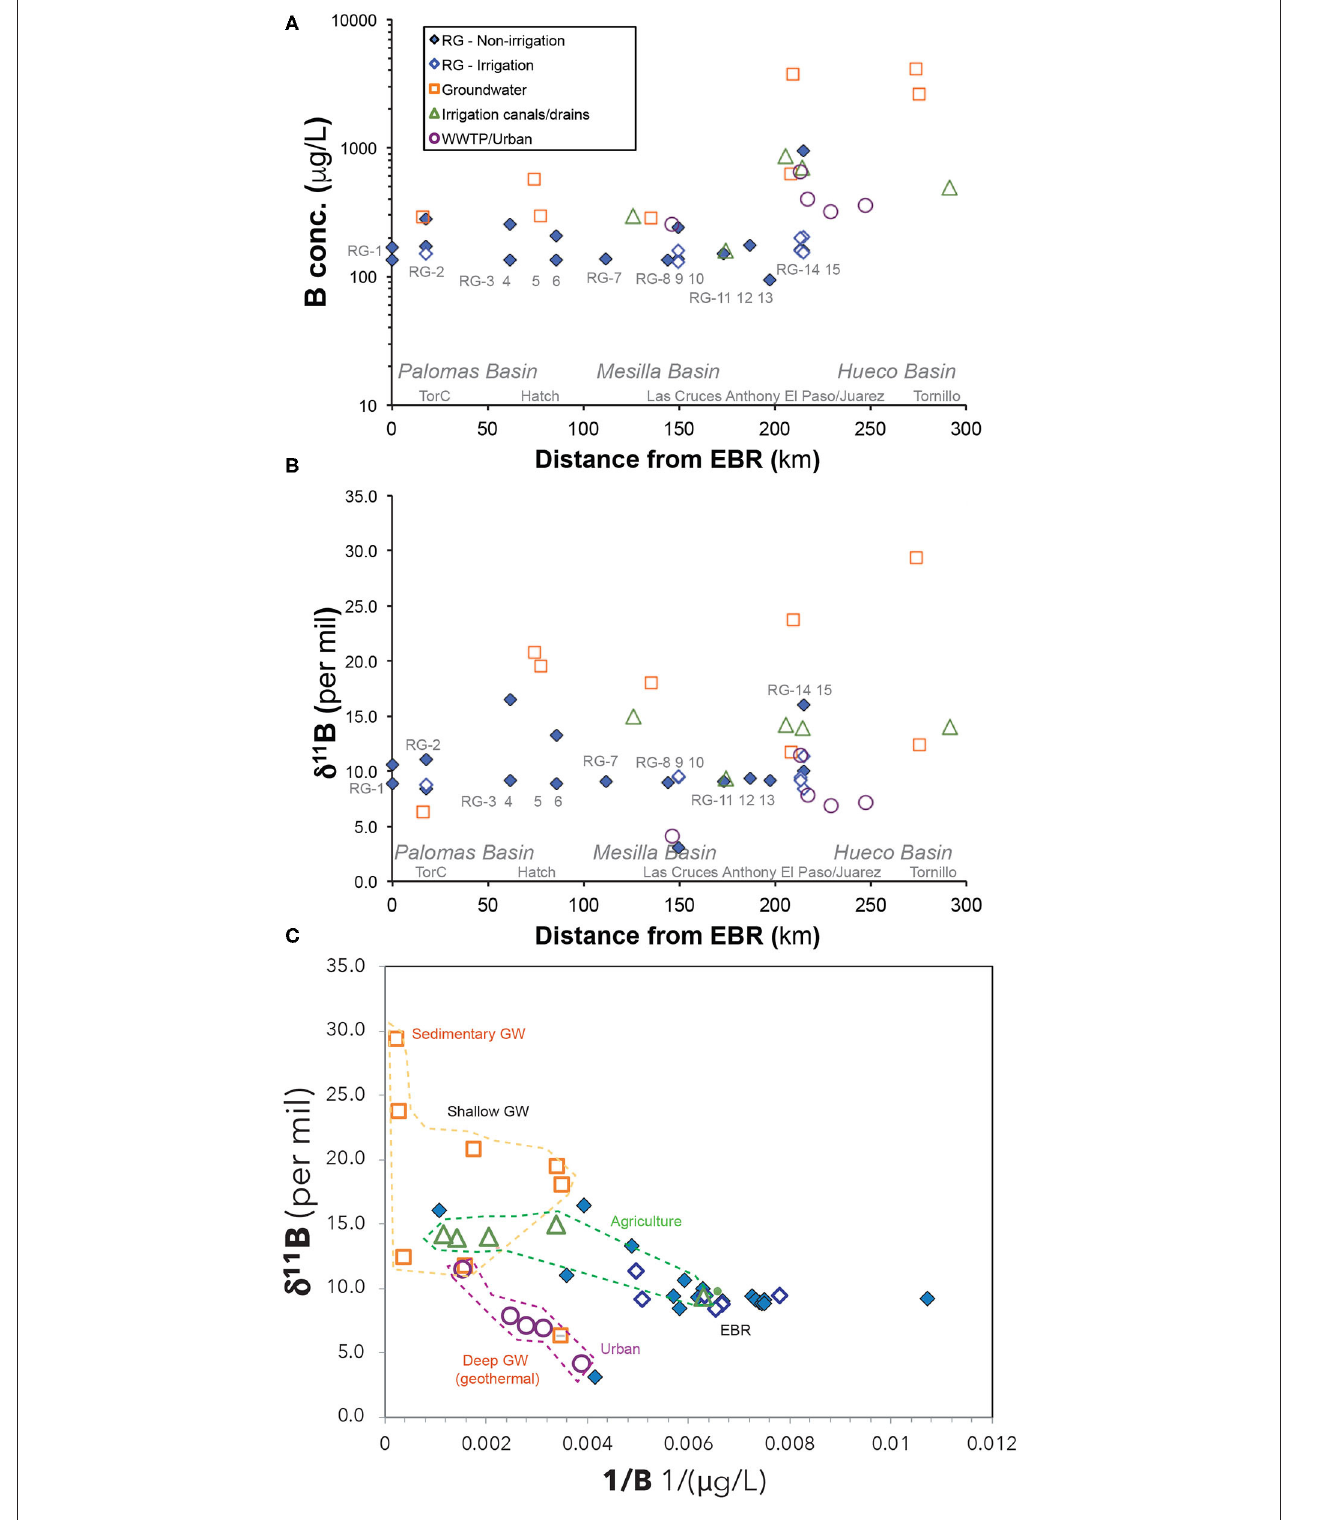
FIGURE 6 | (A) Boron concentrations and (B) B isotope ratios in the Rio Grande river water, groundwater, agricultural canals and drains, and urban water (waste water treatment plants). The Rio Grande water is divided into non-irrigation and irrigation seasons. The sample locations are placed with distance (km) from Elephant Butte Reservoir along the Rio Grande. (C) B isotope ratios vs. 1/B concentrations. End members for Elephant Butte Reservoir, shallow groundwater, deep groundwater, agricultural water, and urban water are indicated and outlined.